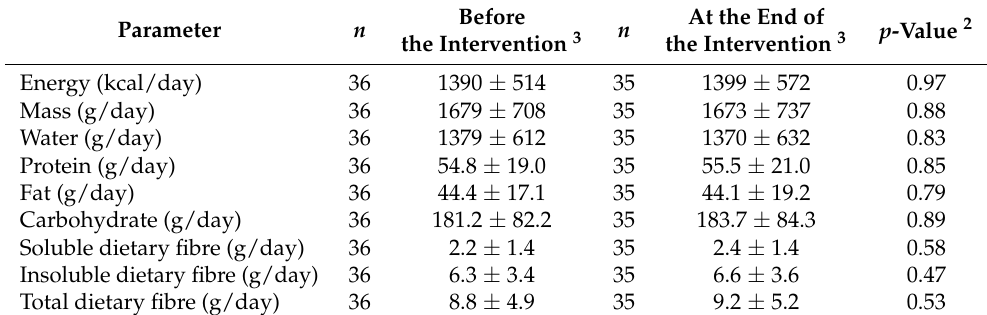
Table 2. Diet survey 1 .